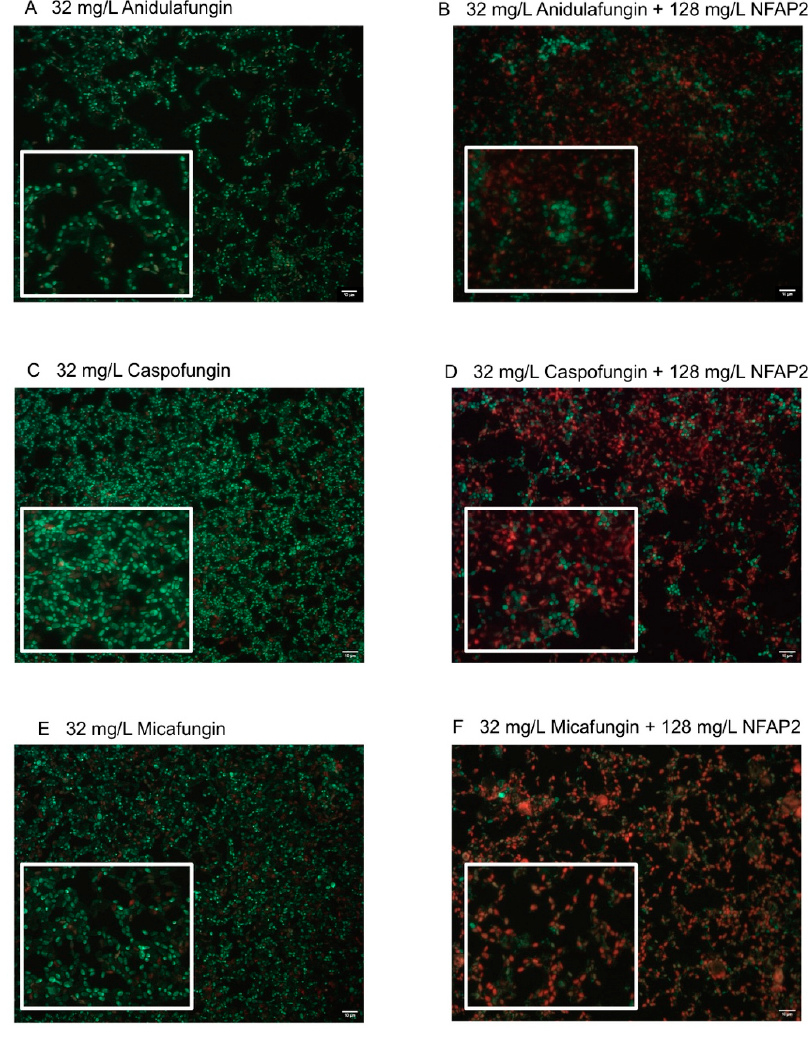
Figure 3. LIVE/DEAD fluorescence imaging of one representative C. auris isolate (isolate 10). Images ( A , C , E ) demonstrate the anidulafungin-, caspofungin- and micafungin-exposed biofilms (32 mg/L), respectively, while images ( B , D , F ) show the anti-biofilm effect of anidulafungin, caspofungin and micafungin (32 mg/L for each drug alone) in the presence of NFAP2 (128 mg/L), respectively. Live cells (green) and nonviable cells (red) were stained with Syto9 and propidium iodide, respectively. All images show typical fields of view. Scale bars represent 10 μ m.